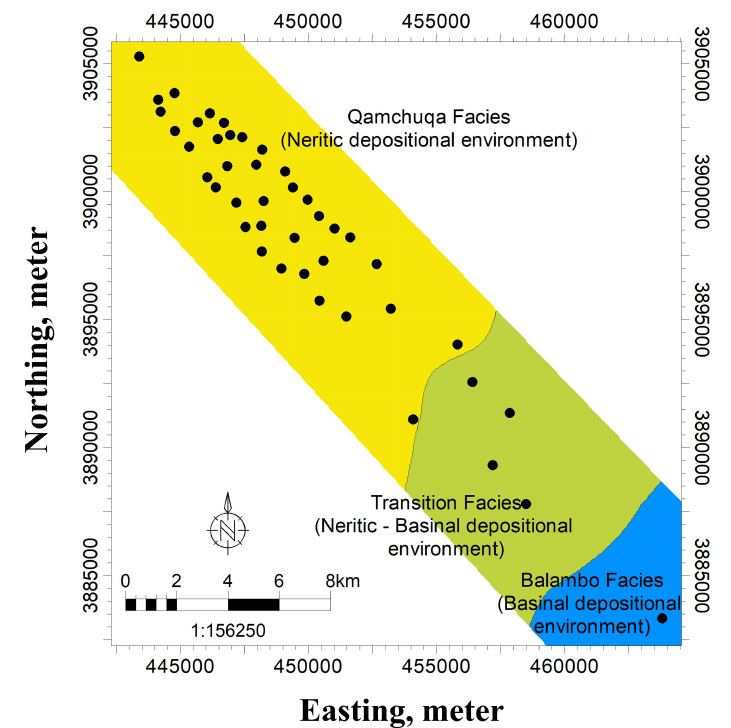
Figure 11. Depositional environment of the Cretaceous reservoir, Jambur field. The black dots refer to the